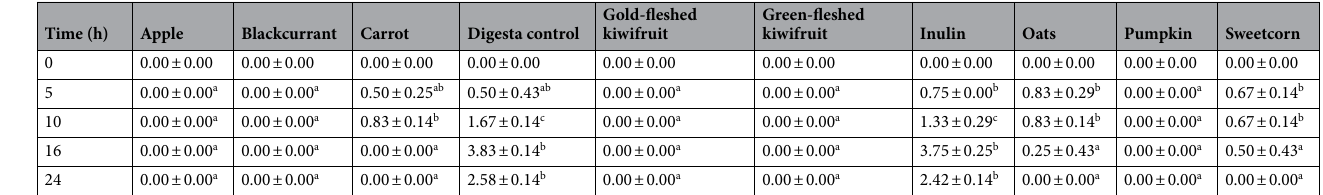
Table 3. Gas production (headspace PSI) during fermentation of substrates. Values are mean of three replicates. S.E. shown. At each time point, the significance due to the substrate was P < 0.001. Within a time point, means with letters in common are not significantly different. Tukey’s HSD